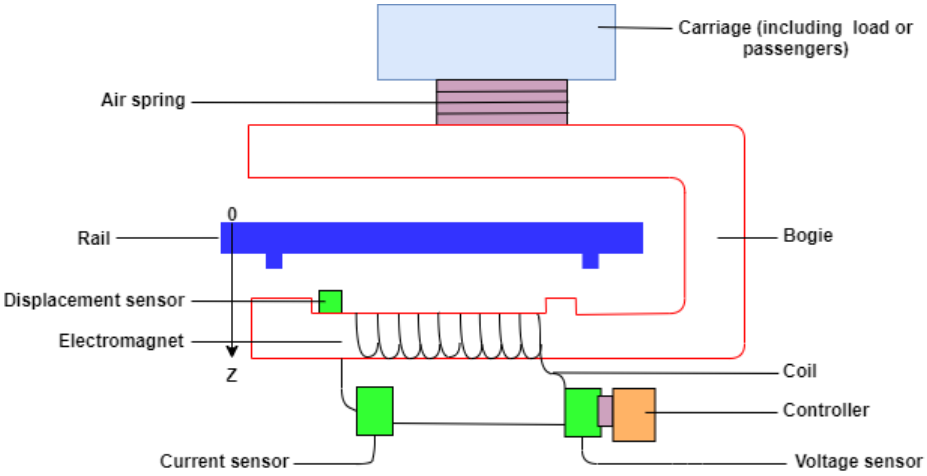
Figure 1. Suspension system of a displacement, current, and voltage sensor configured electromag- netic system for a Magnetic Levitation (Maglev)